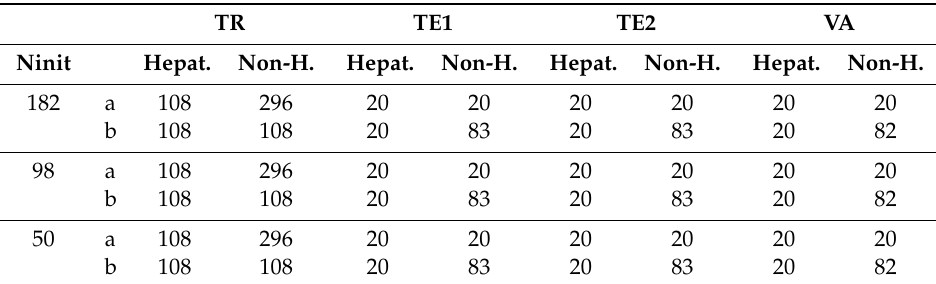
Table 1. Distribution of compounds into classes for the datasets used.